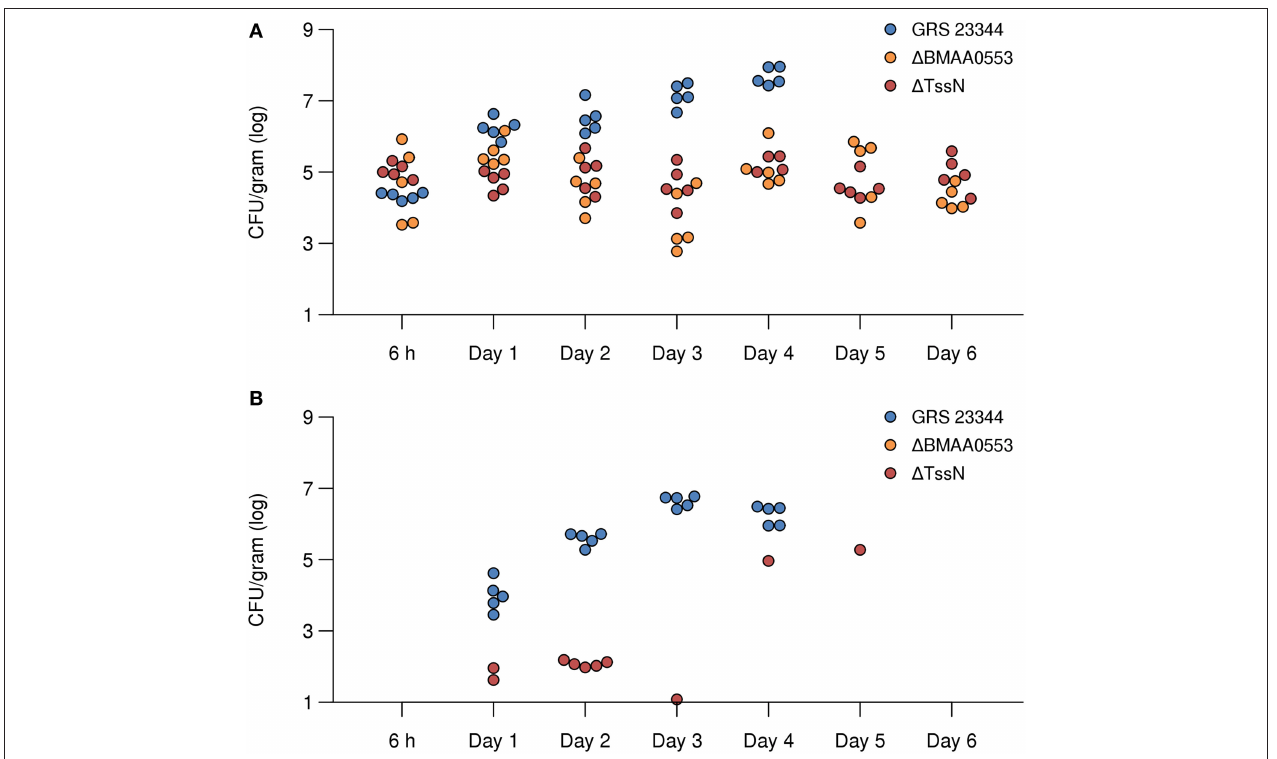
FIGURE 6 | Bacterial dissemination after infection in the lung and spleen in mice. Recovered CFUs from the lung (A) and spleen (B) are shown for time points ranging from 6h to 6 days after aerosol exposure with parental strain GRS 23344 (blue), or the deletion strains 1 BMAA0553 (orange), and 1 TssN (red). In mice challenged with 1 BMAA0553, none had > 10 CFUs recovered from the